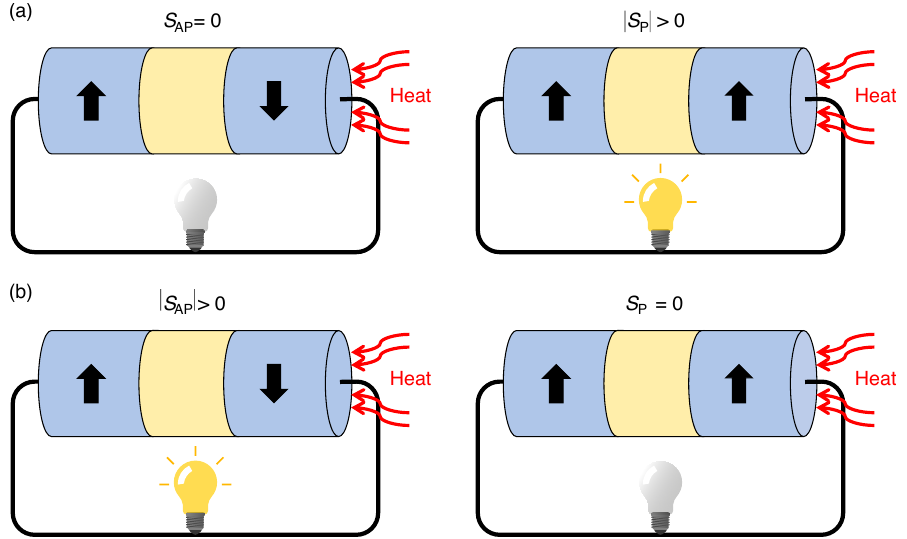
Figure 5. Schematics of a thermoelectric generator based on FM/Cu/FM NWs where ( a ) βη = − 1 and ( b ) βη = 1, leading to S AP = 0 and S P = 0,